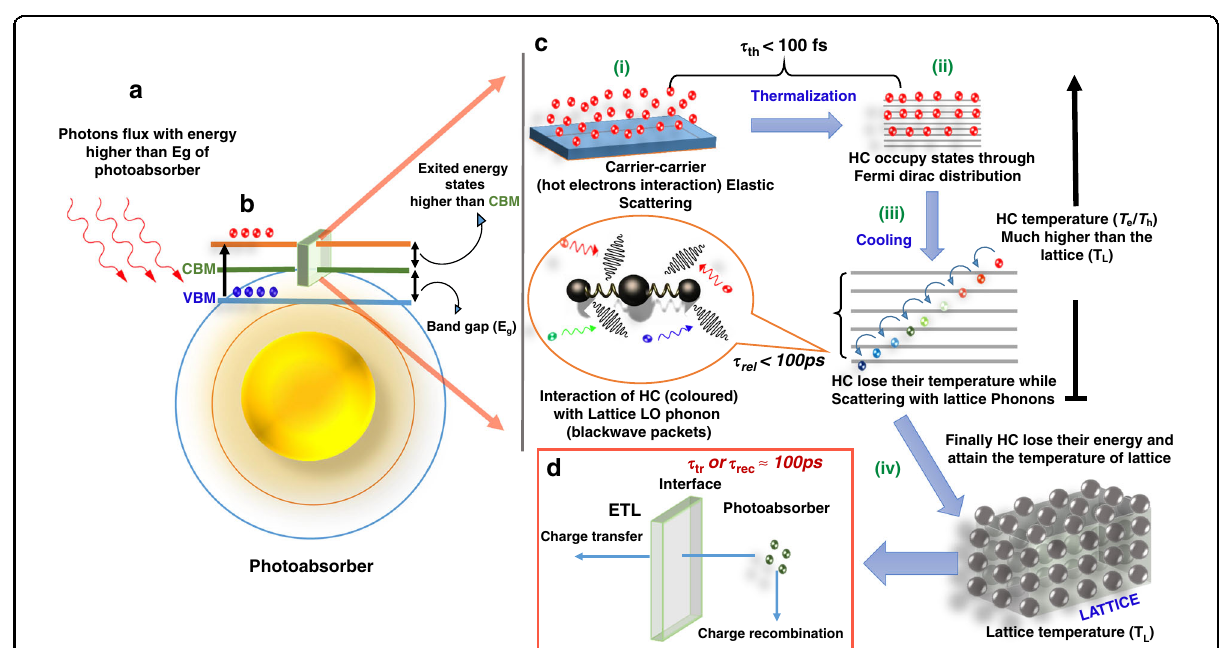
Fig. 4 The formation of HC, their interactions, and fi nally the cooling down to lattice temperature. In this image, “ HC ” refers to hot electrons. A similar phenomenon takes place for hot holes as well. a Absorption of high-energy photons by a photoabsorber. b Electrons from the valence band maximum (VBM) of an absorber material jump to energy states higher than conduction band minimum (CBM). The detailed phenomenon of HC is presented in ( c ): (i) carrier – carrier scattering, (ii) the thermalization of HC to occupy energy states through Fermi – Dirac distribution, (iii) cooling through their interaction with LO phonons, and (iv) fi nally the loss of their energy to attain lattice temperature. d The charge carrier either transfer to the electron-transport layer (ETL) or recombination takes